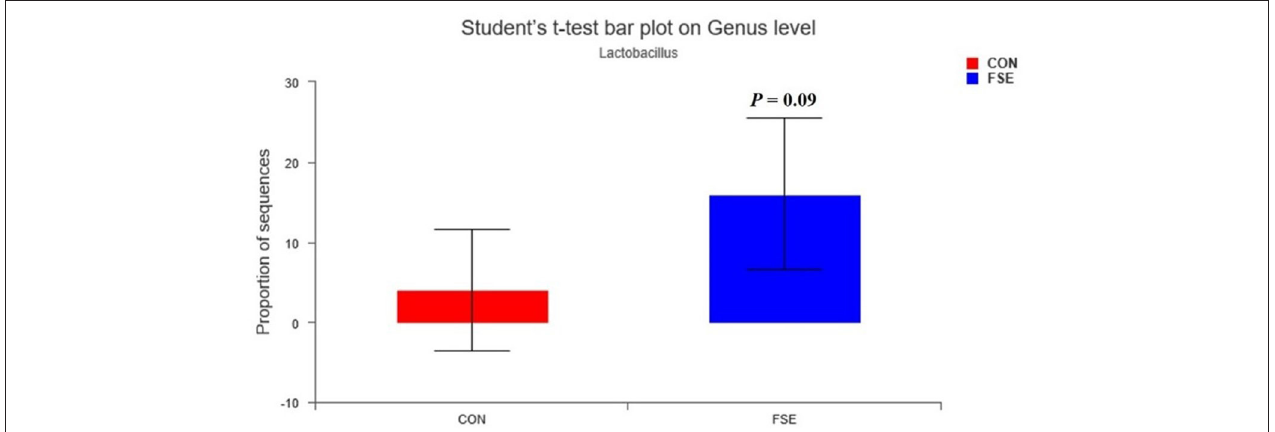
FIGURE 8 | Effects of Forsythia suspensa extract fed to sows on Lactobacillus community in feces of sows. The different colors represented the different treatments. The results presented as mean values of the bacteria, n = 4. CON, control; FSE, Forsythia suspensa